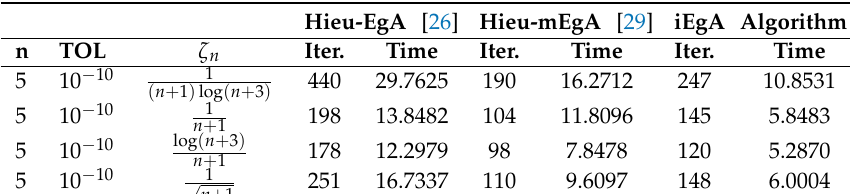
Table 2. Example 3: Numerical results for Figures 8–11.